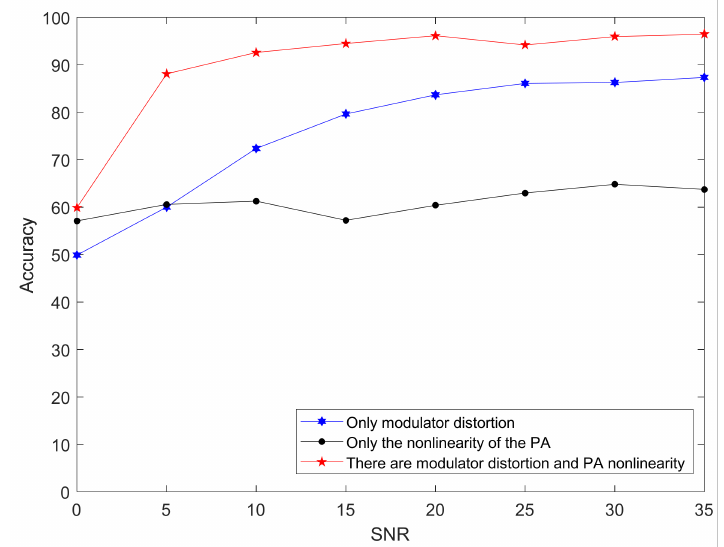
Figure 16. Classification-accuracy rate of three different models through CNN classifier under different signal-to-noise ratio conditions.